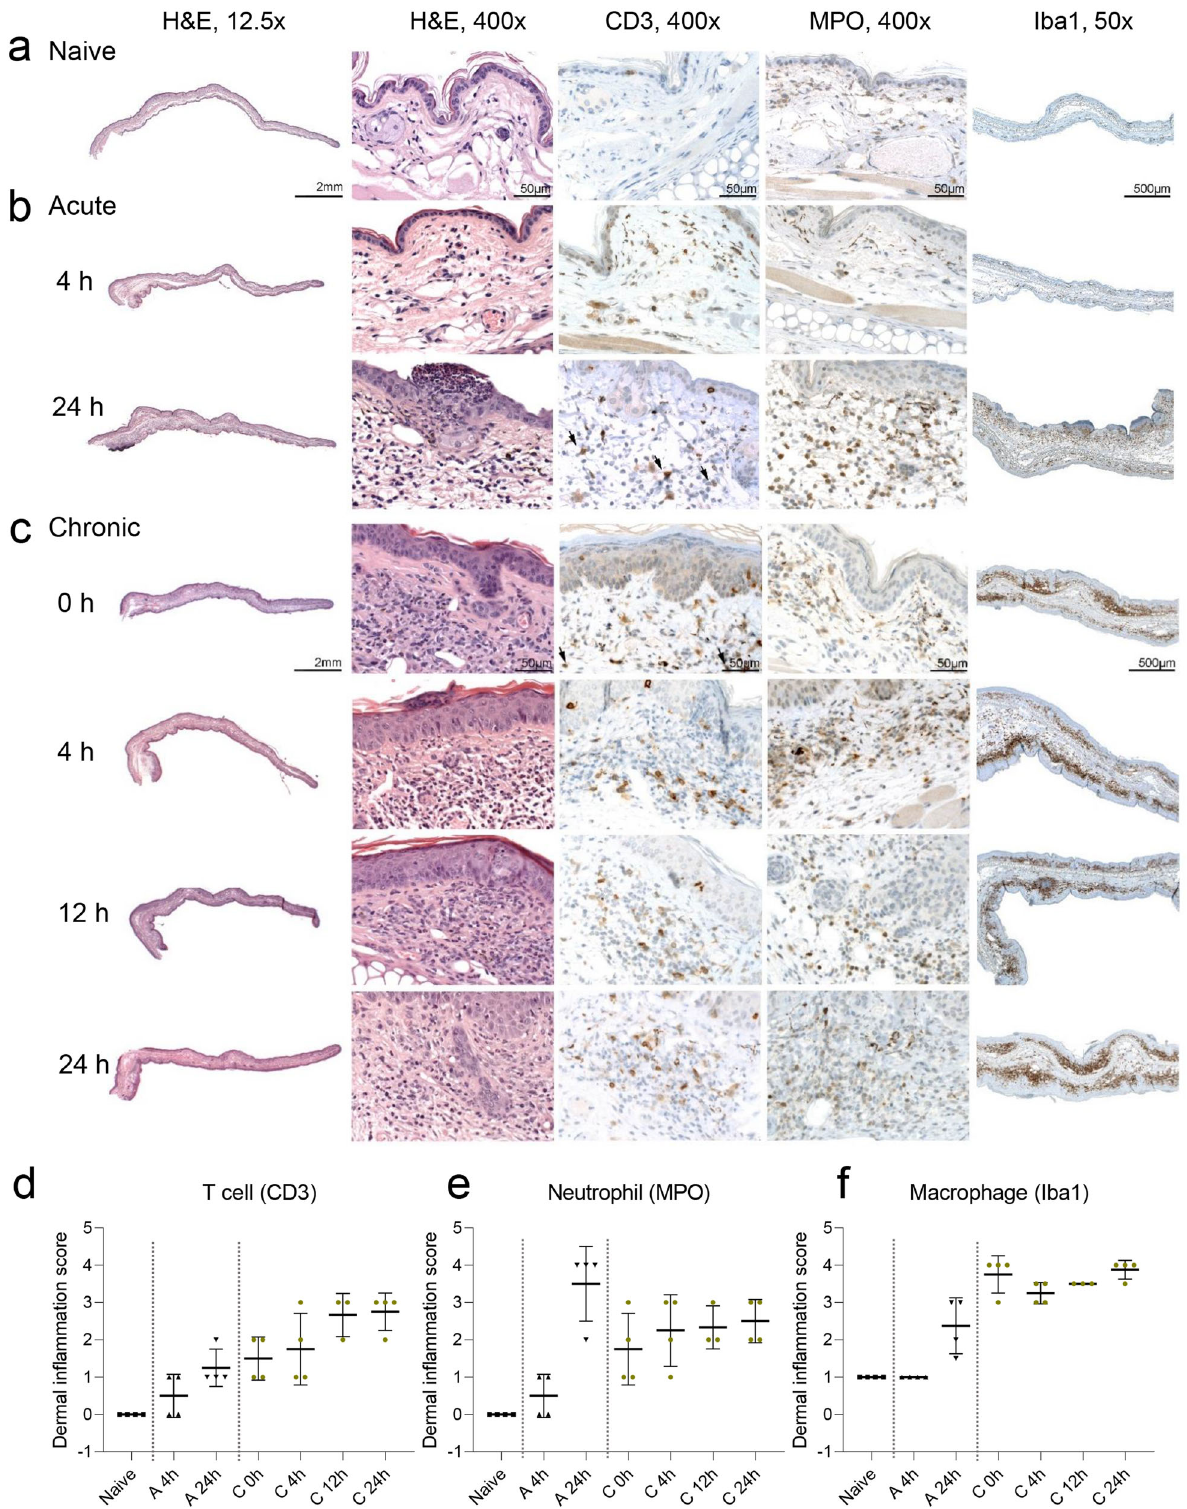
Fig. 3 Histopathological (H&E) and immunohistochemical (IHC) characterisation of the in fl ammatory immune cell in fi ltrate during acute and chronic cutaneous DTHR. Naive ears ( a ), in fl amed ears with acute ( b ) cutaneous DTHR (4 h and 24 h) and ( c ) chronic cutaneous DTHR (0 h, 4 h, 12 h, and 24 h) H&E staining (magni fi cation ×12.5 and ×400, at the scale of 2 mm), CD3, MPO IHC (magni fi cation ×400, at scale of 50 μ m), and Iba1 IHC (magni fi cation ×50 and scale of 500 μ m). Scoring of dermal CD3 ( d ), MPO ( e ) and Iba1 ( f ) immune cell in fi ltration presented as a scatter plot: mean + / − SD (0 = no in fl ammatory in fi ltrate, 1 = minimal, 2 = mild, 3 = moderate, 4 = severe presence of in fl ammatory cells, n = 4 animals, except chronic 12 h n = 3 animals). Grey dashed lines aid visual separation between naive, acute and chronic